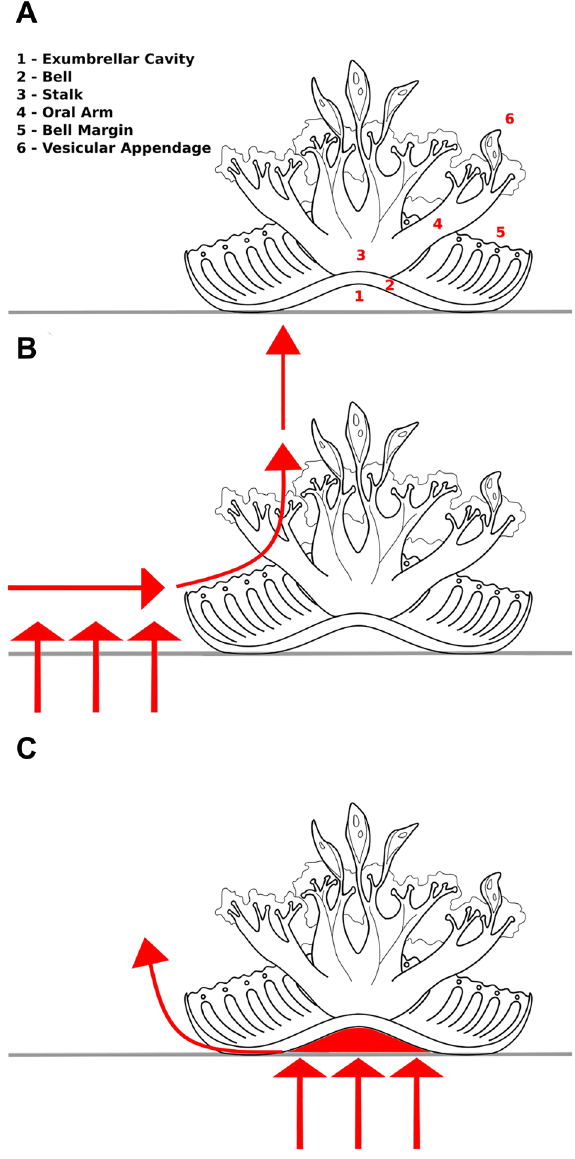
Figure 1. Hypotheses. Possible mechanisms for porewater transport by Cassiopea. Upside-down jellyfish are typically found on the benthos with their aboral side against the substrate and their oral surface facing upward. ( A ) The relevant anatomy of Cassiopea sp. includes the exumbrellar cavity, the water-filled space between the bell below the stalk and the benthos. ( B ) One of the tested hypotheses was that porewater would be liberated from the surrounding benthos via Bernoulli’s principle, below the region of relatively high-velocity water flow in the animal’s feeding current. ( C ) The other hypothesis under investigation was the “suction pump” mechanism, in which pressure fluctuations in the exumbrellar cavity draw porewater upwards below the bell, which is then released laterally as the bell moves in the process of bell